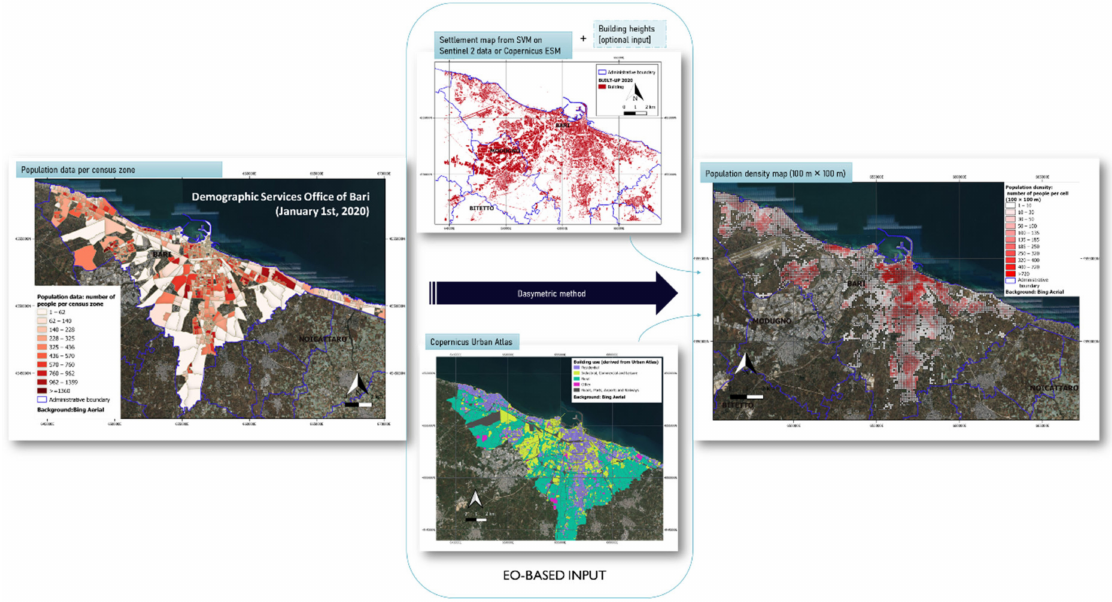
Figure 3. Graphical scheme of the dasymetric method proposed in